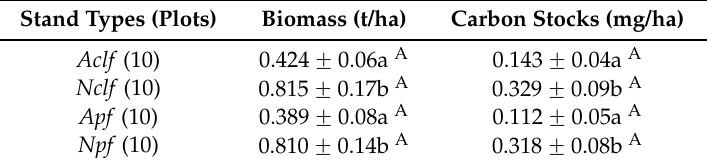
Table 2. Biomass and carbon stock of fallen trees for different stand and forest types.